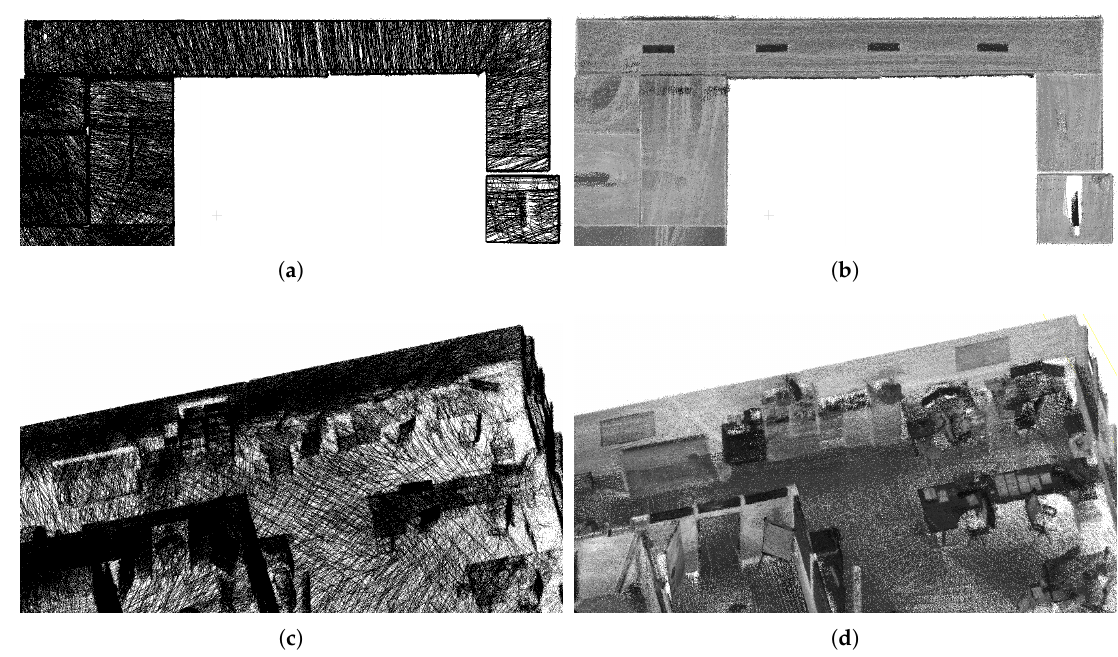
Figure 23. The comparison of data density provided by ZEB-1 ( a , c ) and our ( b , d ) solution. Since the ZEB-1 solution is based on the Hokuyo scanner, the laser intensity readings are missing and data density is much lower compared with our solution. Multiple objects which can be distinguished in our reconstruction (lamps on the ceiling in the top, furniture and other equipment in the bottom image) are not visible in the ZEB-1